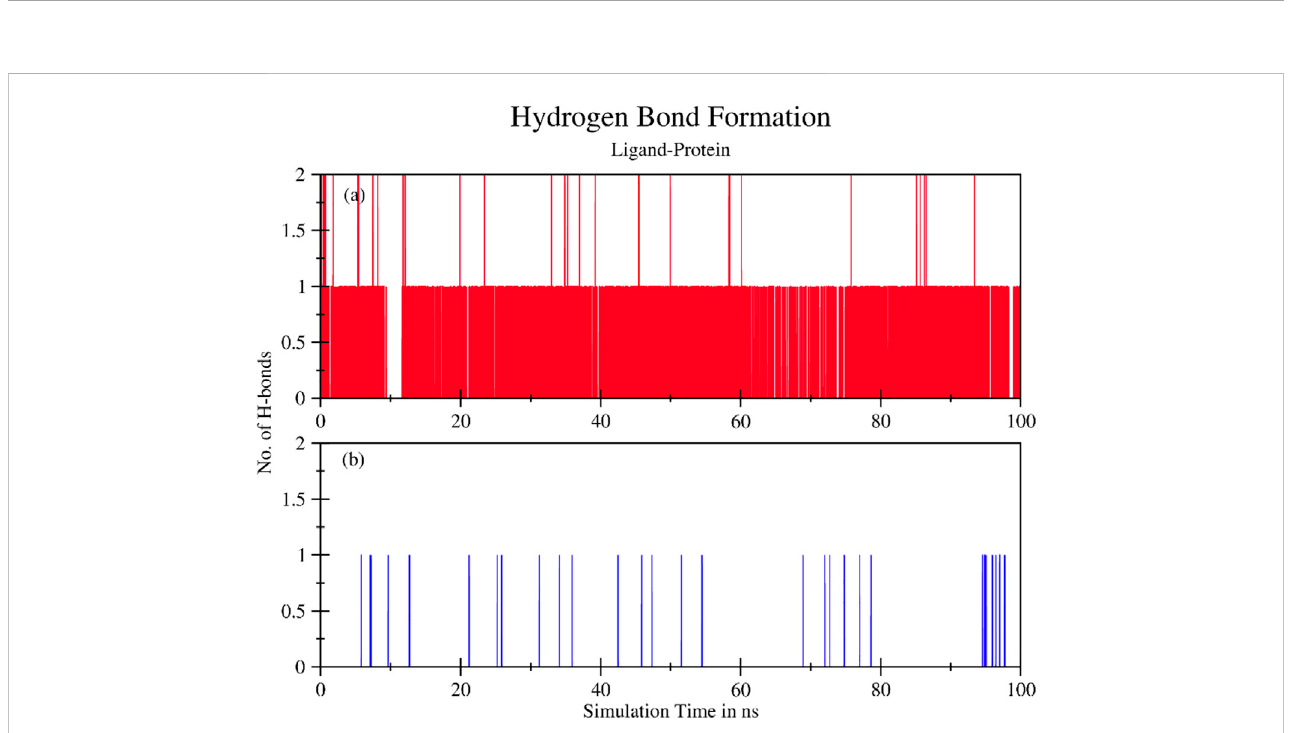
FIGURE 8 The total number of hydrogen bonds formed between ligand and protein during 100 ns simulation time for (A) TNF compound complex and (B) TNF (2az5) inhibitor complex. Ligand exhibits hydrogen bonds and forms consistent interactions with protein in the (A) System. In (B) No signi fi cant H-bonds are